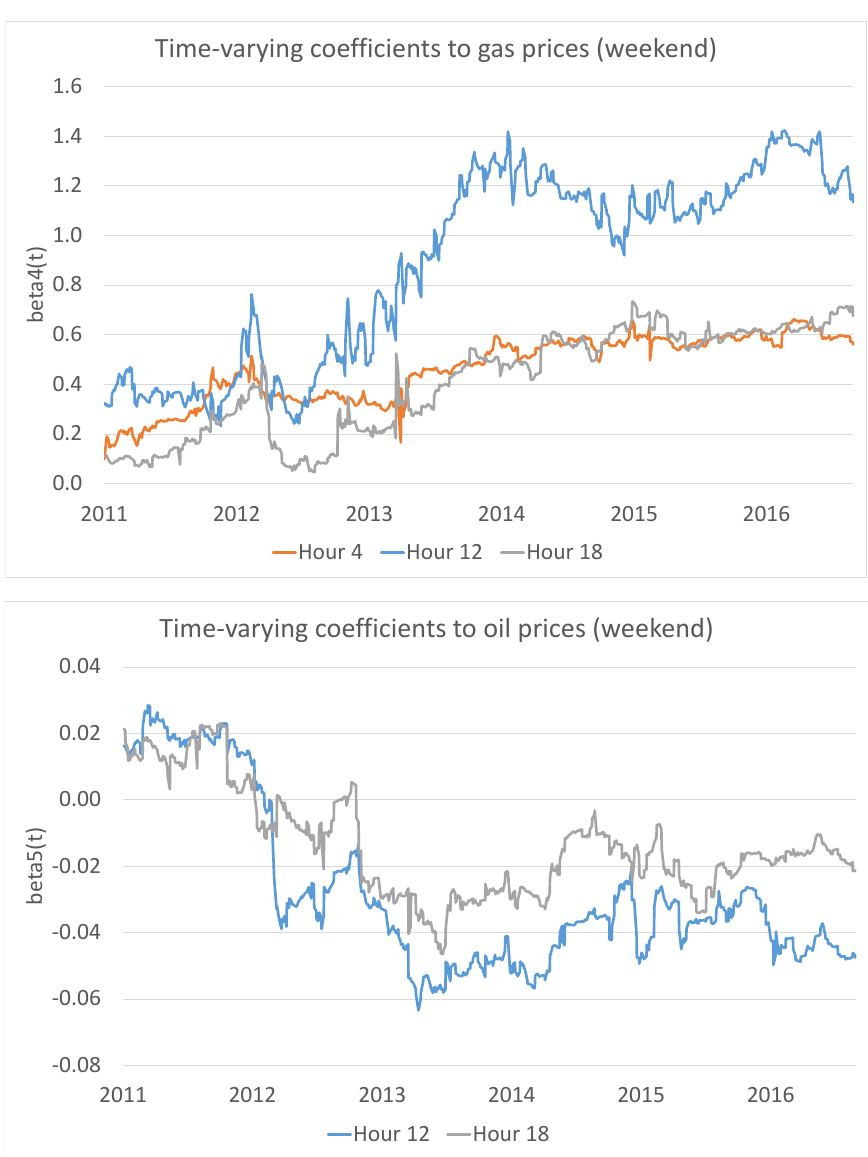
Figure 12. Time-varying coefficients of gas and oil prices. The coefficients have been estimated for the sample period from 1 January 2011 until 31 August 2016 with respect to the key hours H4, H12 and H18 on weekend